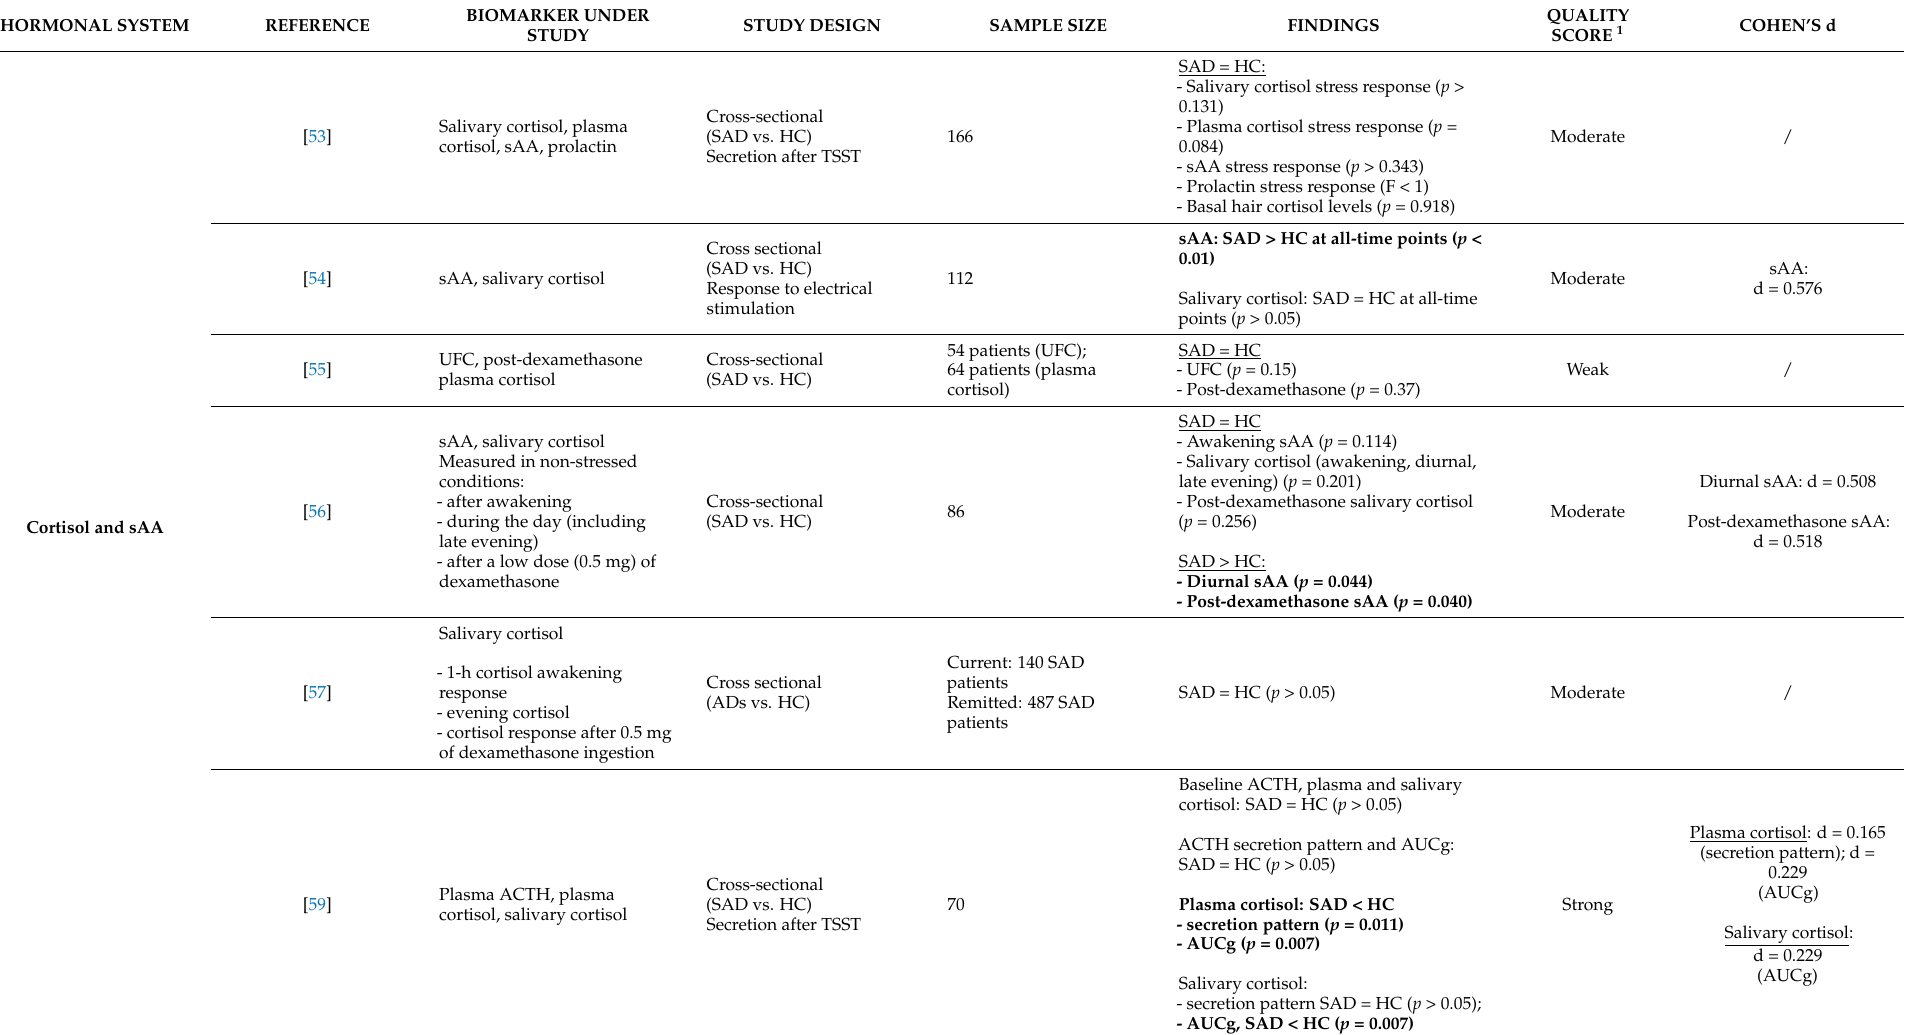
Table 2. Summary of findings regarding endocrine biomarkers of